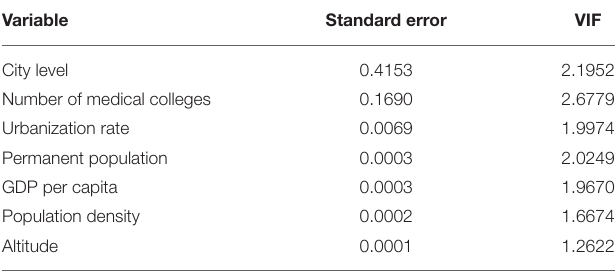
TABLE 3 | Results of variable collinearity